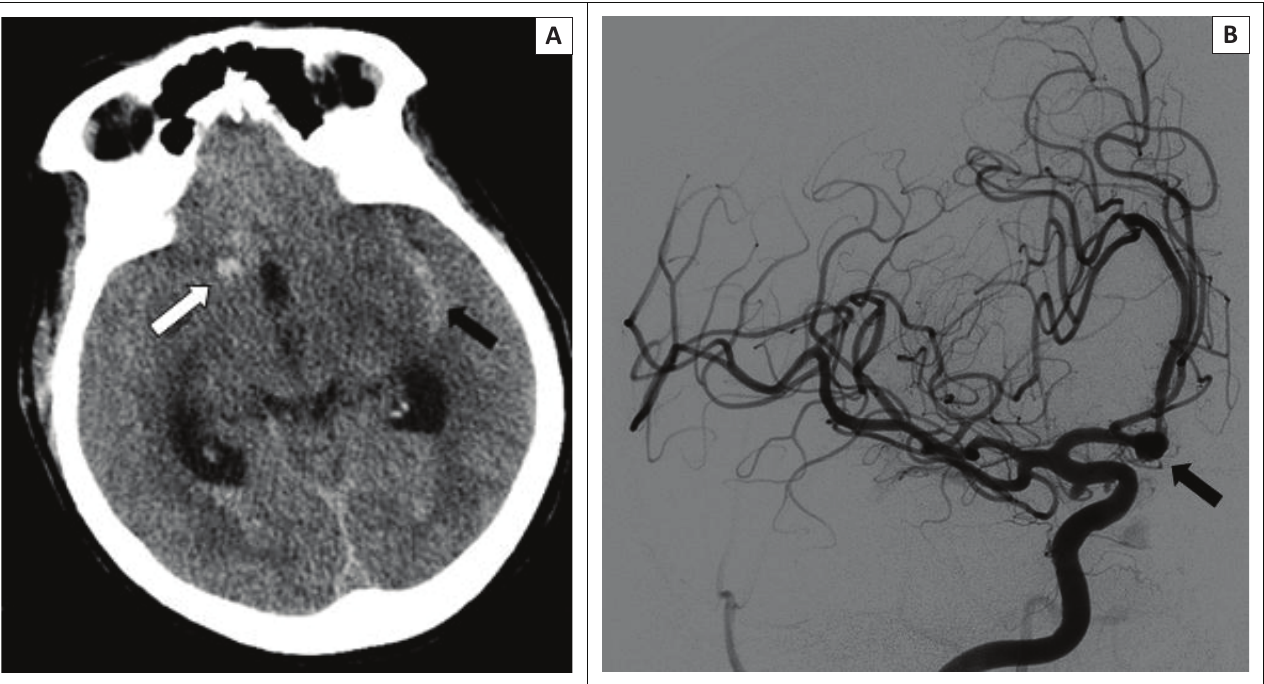
FIGURE 1: (a) Subarachnoidal haemorrhage in the left sylvian fissure (black arrow) and focal haemorrhage to the right of the third ventricle (white arrow) on precontrast computed tomographic scan; (b) Digital subtraction angiography demonstrates anterior communicating artery aneurysm (black